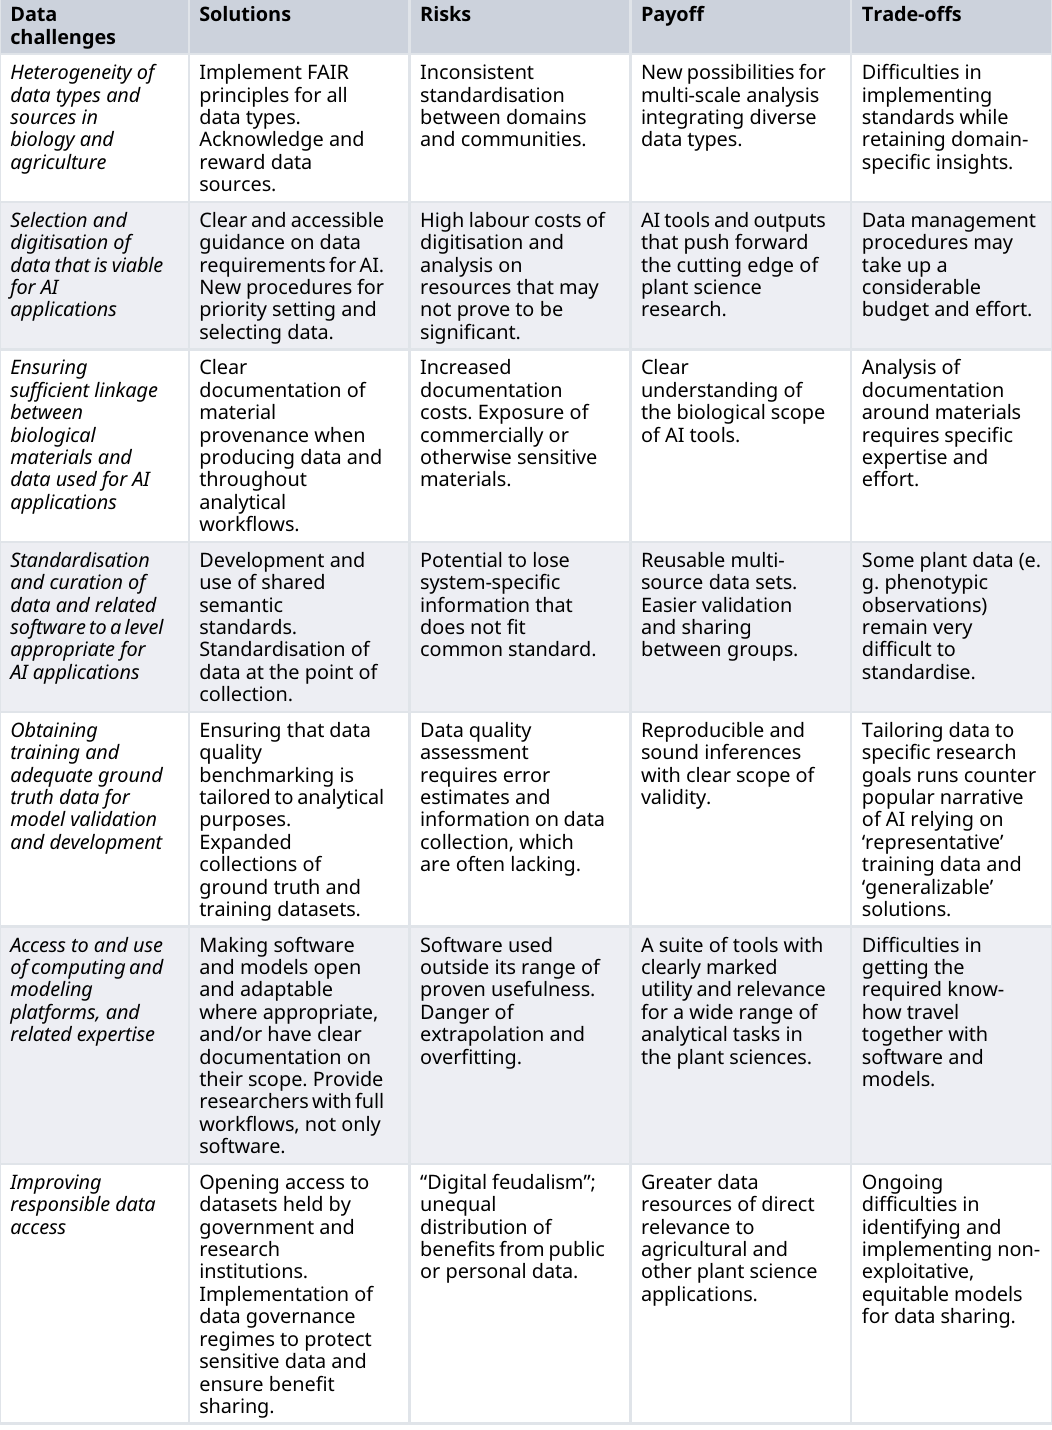
Table 1. Synoptic view of the data challenges, possible solutions and what can be lost and gained by investment in those areas. Data